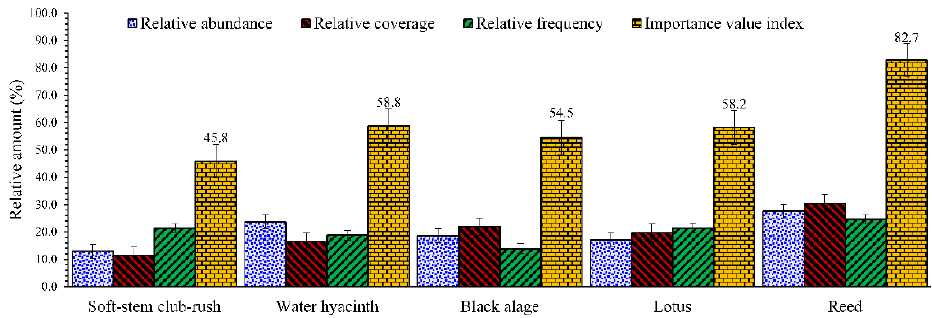
Figure 3. Average important value index of aquatic plants.